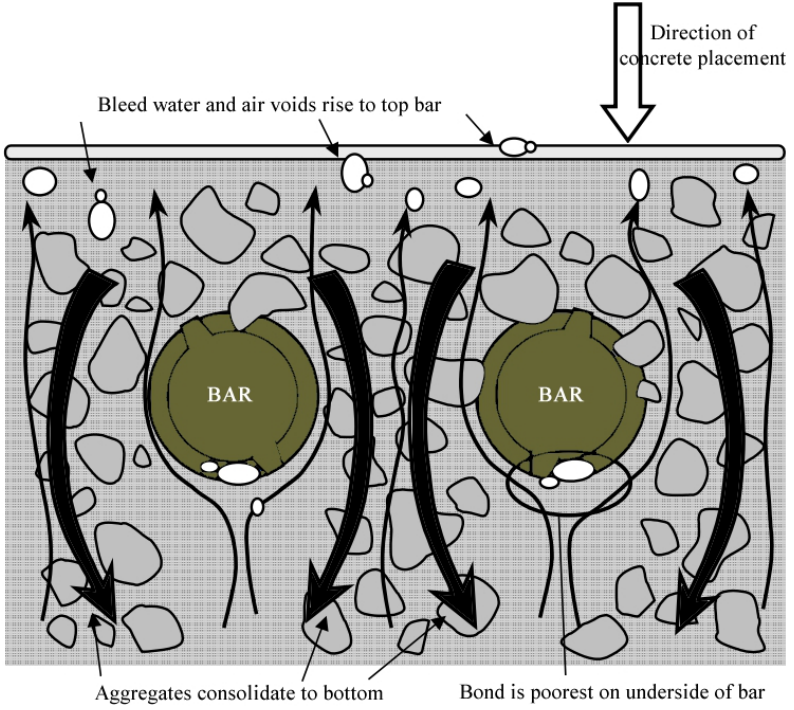
Figure 8. Effect of reinforcement position on bond strength [67].